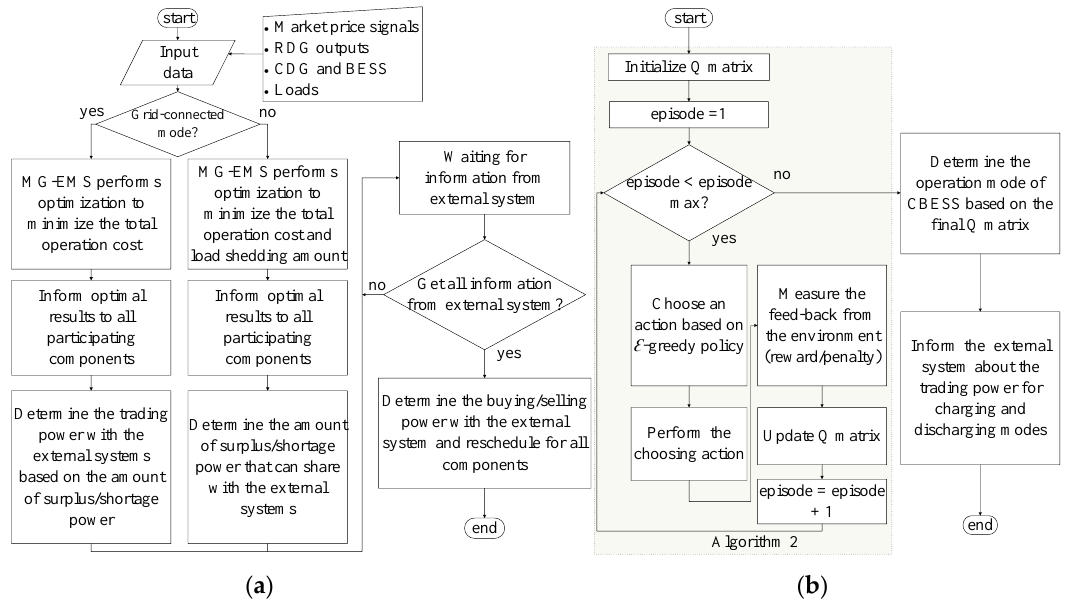
Figure 4. Flowchart for operation strategy: ( a ) MG-EMS; ( b ) CBESS.